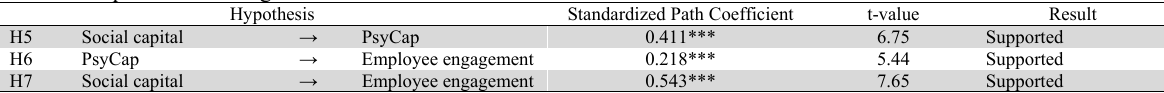
Structural equation modeling